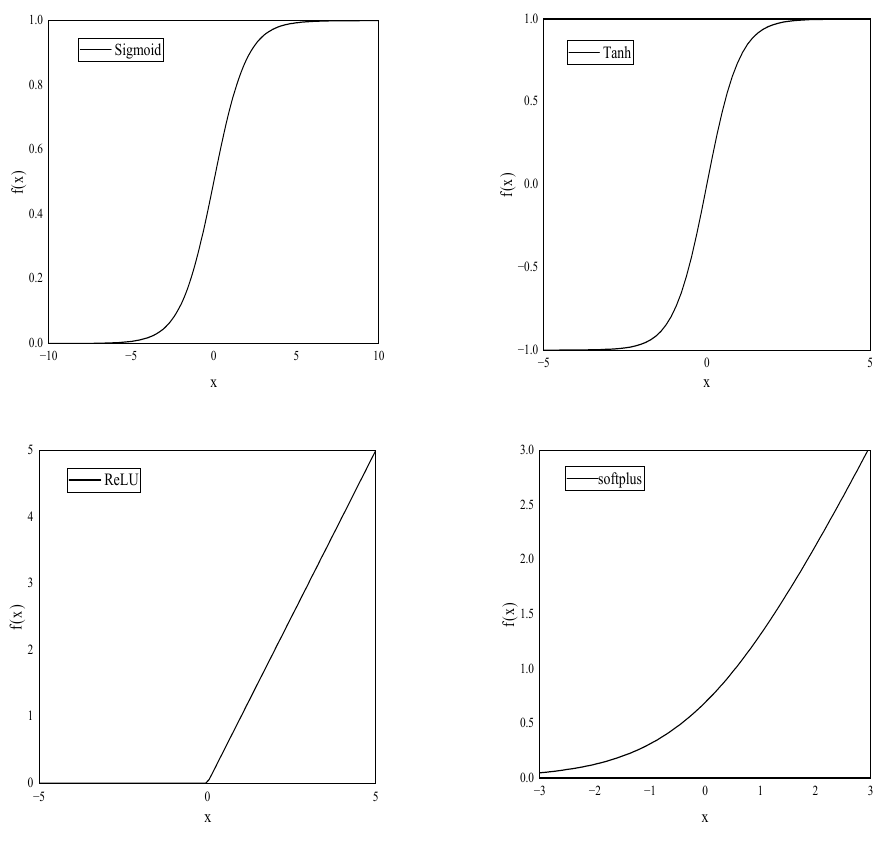
Figure 4. Four activation functions.